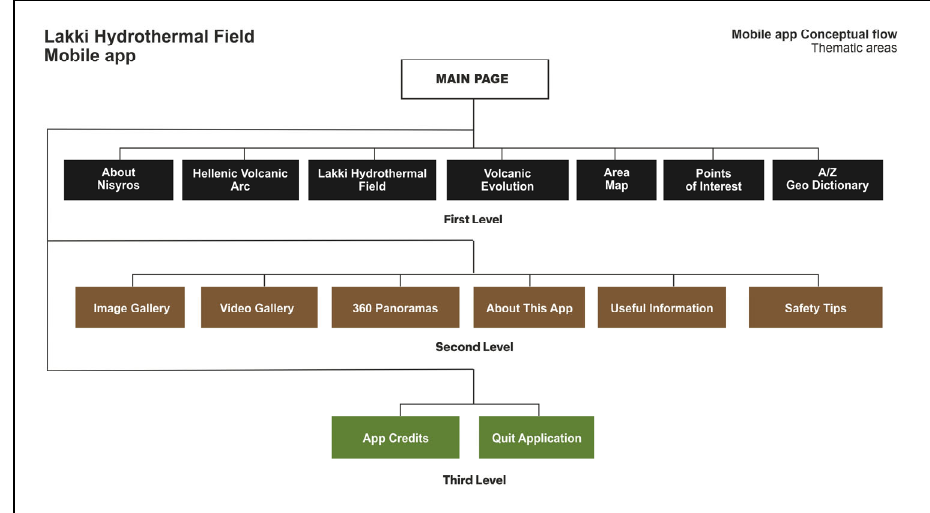
Figure 10. Conceptual flow of the ‘Nisyros Volcano App’, showing the different informational levels.